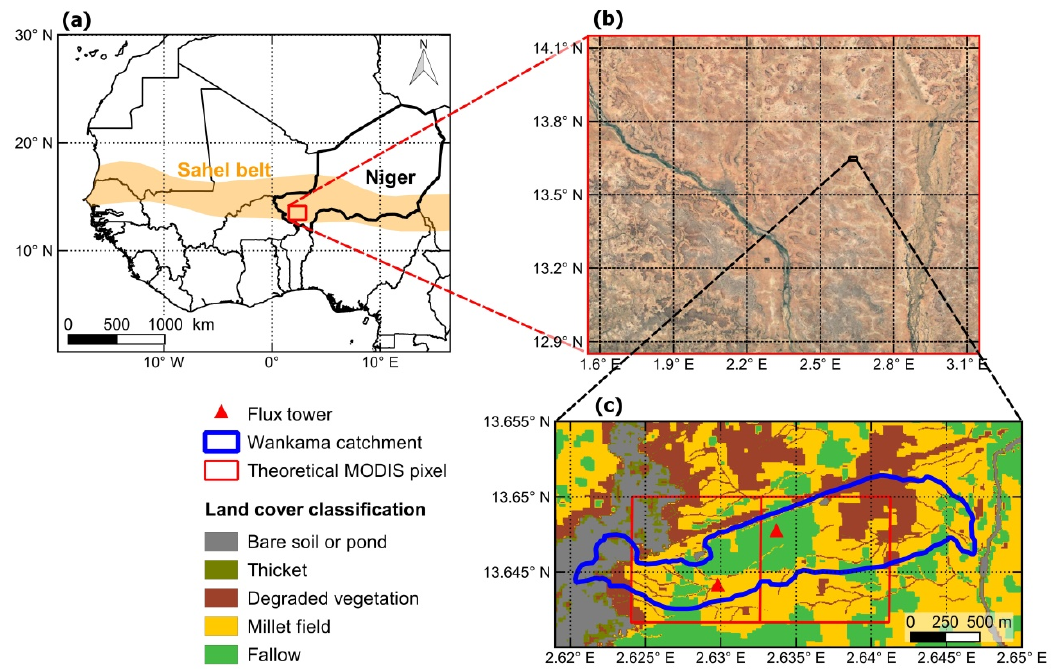
Figure 1. ( a ) Location of study area in South West Niger, West Africa; ( b ) Satellite view of the study mesosite (Google Earth, Image Landsat / Copernicus, image © 2017 DigitalGlobe, image © 2017 CNES / Airbus); ( c ) Local-scale Wankama catchment with location of two eddy covariance (EC) flux towers and of corresponding theoretical MODIS pixels, with land cover map derived from a 2005 SPOT image.